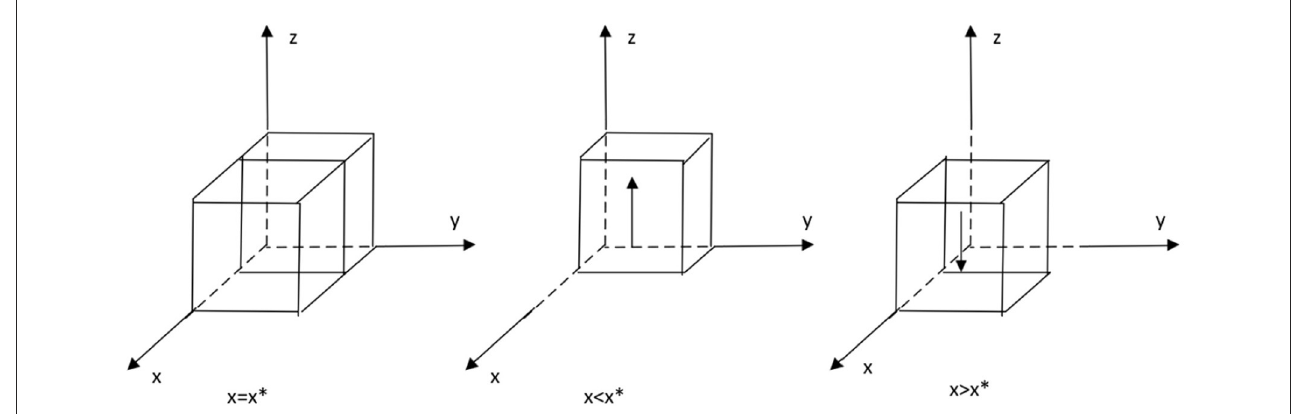
FIGURE3 Phase diagram of the evolution of the public’s